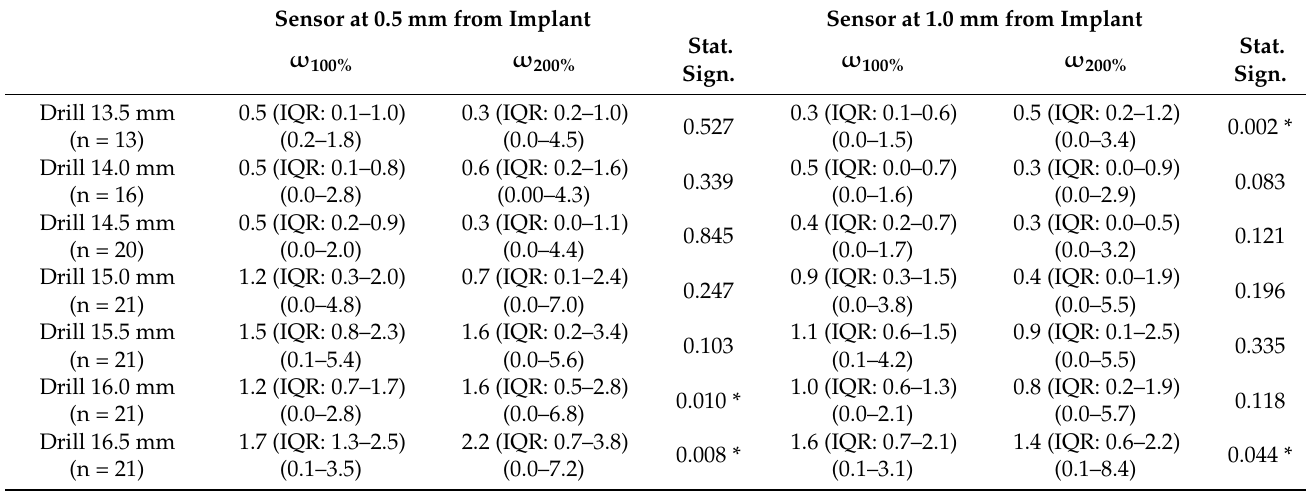
Table 2. The median for the maximum temperature increase in ◦ C for each surgical step at two different speeds, the inter-quartile range (IQR), and the range (min–max). Statistically significant differences were found for the 13.5, 16.0, and 16.5 mm drills and thread